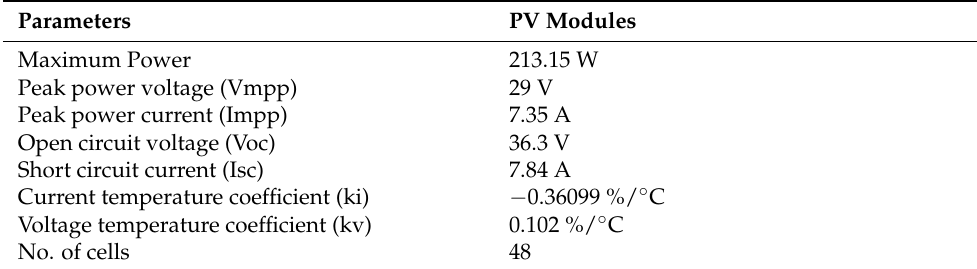
Table 3. PV cell JY-210-A